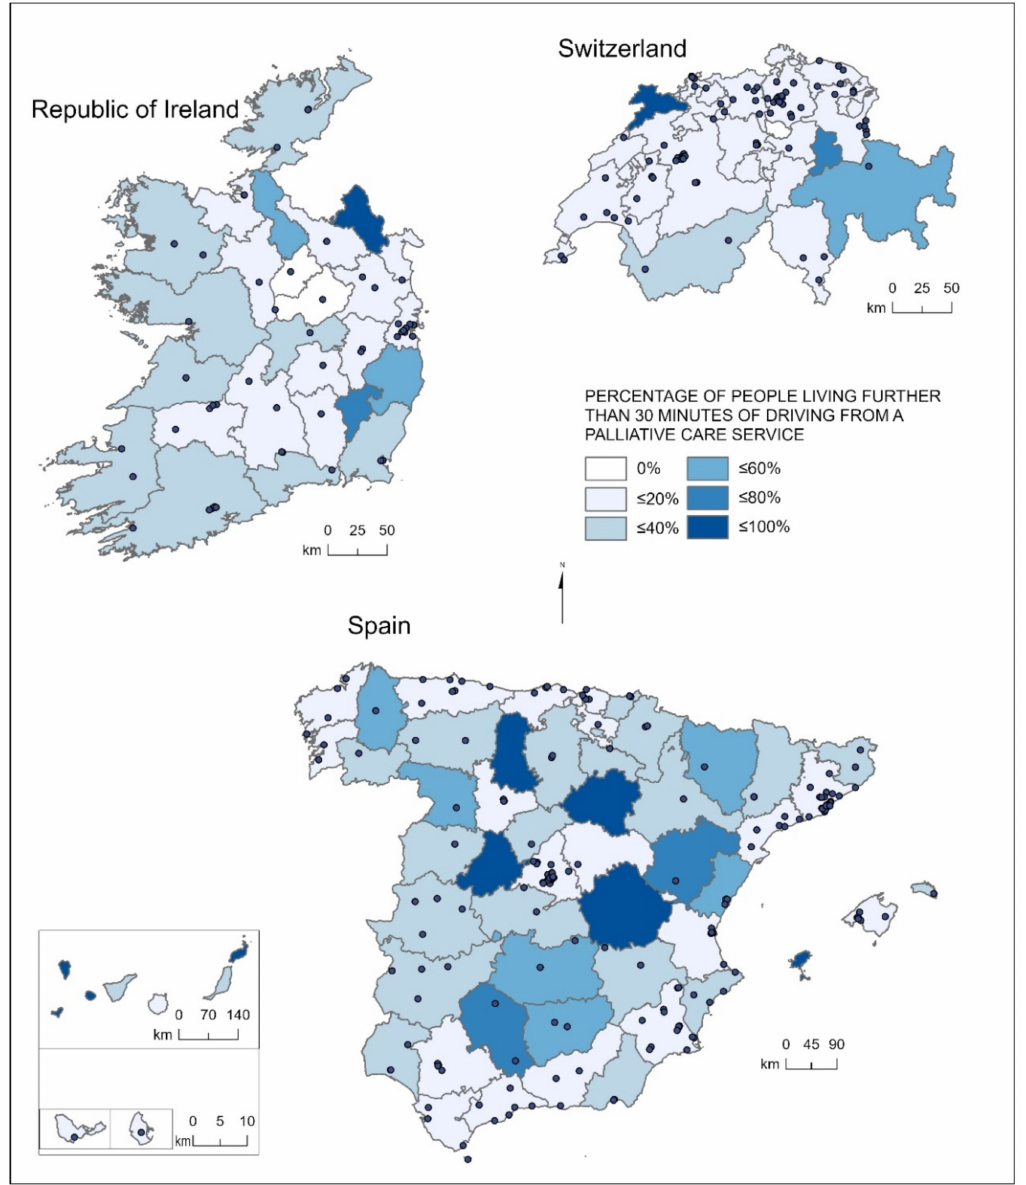
Figure 2. Percentage of people living further than a 30-min drive from a specialized palliative care service in Ireland, Spain, and